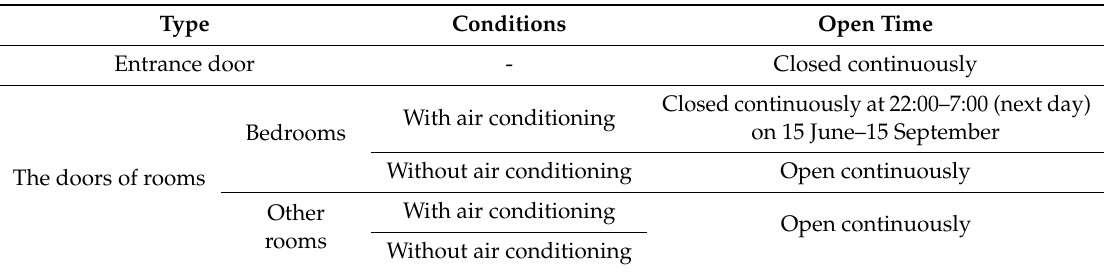
Table 9. Open / closed time of the doors in the simulation.